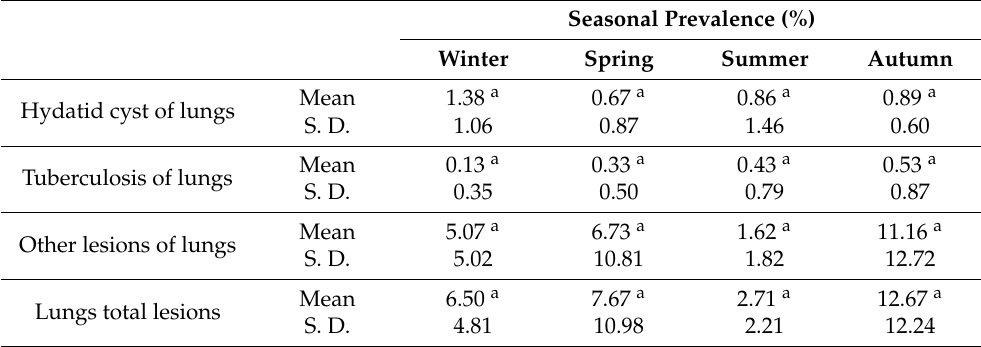
Figure 9. The annual average prevalence of different types of lungs lesions (2018, 2019 and 2020). For the seasonal dynamics of the occurrence of pulmonary lesions, it seems that it did not vary significantly ( p < 0.05) despite a higher average prevalence in autumn (12.67%) including that of tuberculosis (0.53%). However, an increase in their mean in winter for hydatidosis (1.83%) was noted (Table 3). Table 3. Comparative distribution of lungs lesions prevalence over